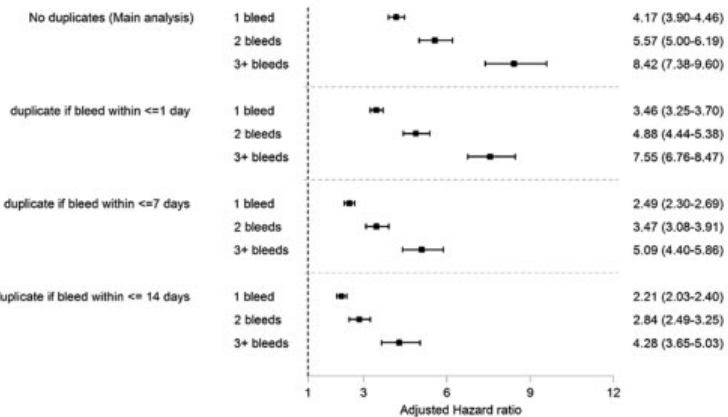
Fig. 2 Results ofsensitivity analysisinvestigating the impactof treating records of bleeds as duplicates if they are recorded within certain timeperiods of each other. The main analysis treats all records of bleeds as separate events of bleeds. Hazard ratios adjusted for all characteristics listed in ► Table 1 .